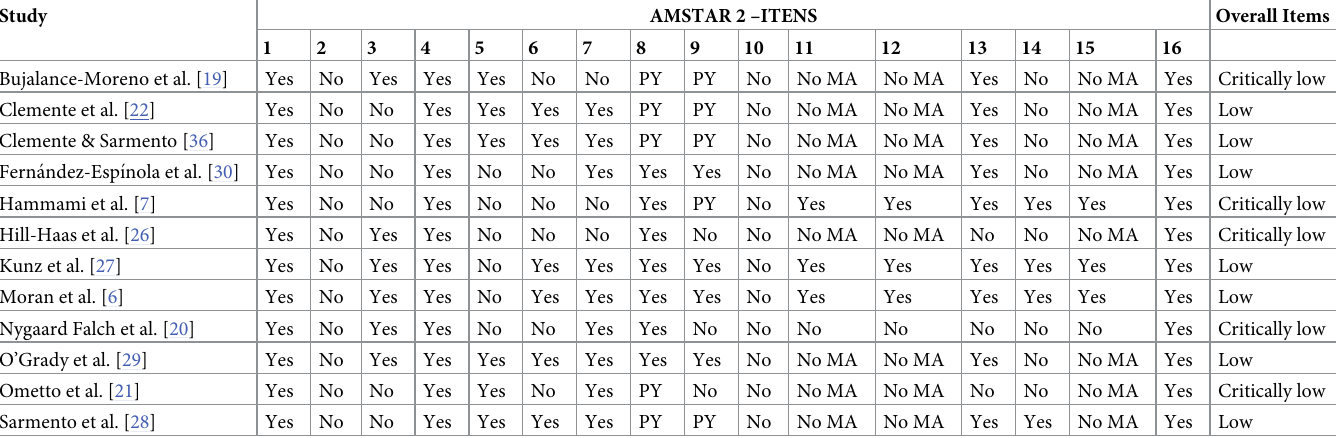
Table 5. AMSTAR 2 assessment of each included SR or